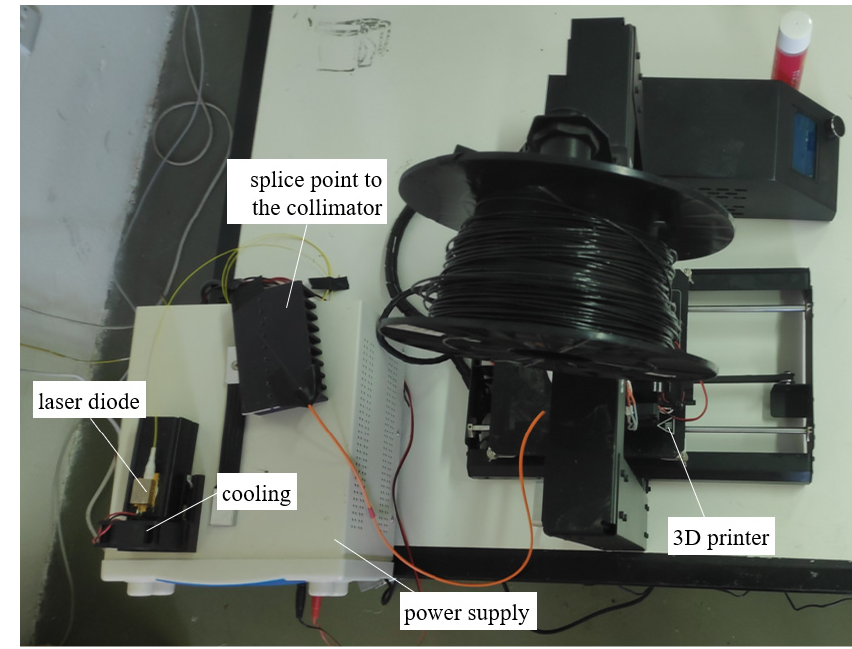
Figure 13. Setup for the Laser Assisted FFF 3D Printer.